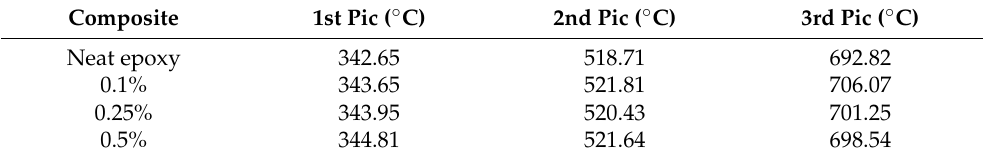
Figure 3. ( a ) Morphology of ZnO-epoxy particles, ( b ) integration of ZnO in epoxy resin (0.5 wt%). Table 2. Temperature pics of the TGA derivative for epoxy-ZnO composites before irradiation.